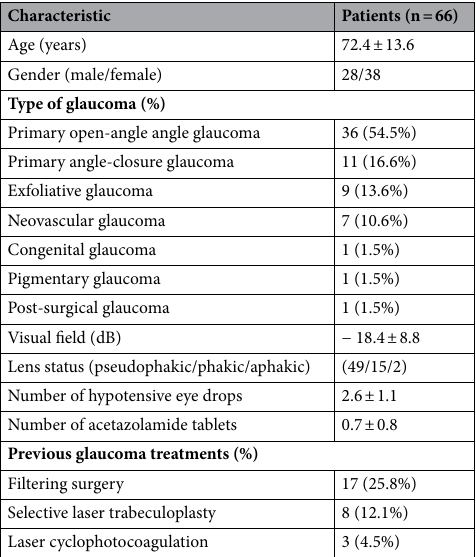
Table 1. Demographical and clinical characteristics of patients treated with ultrasound cyclo